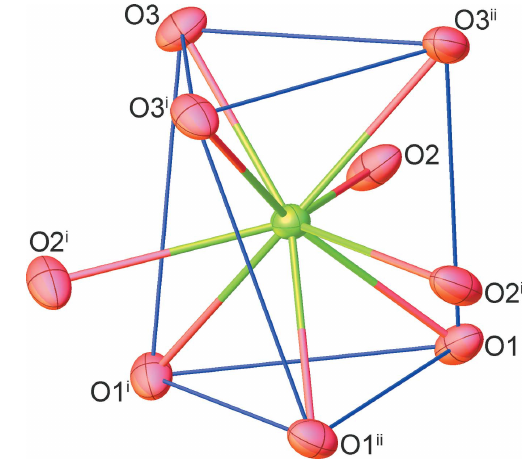
Figure 2 View of the distorted spherical tricapped trigonal prism (TCTPR-9) of the central Eu III ion in the title compound 1 . Symmetry codes: (i) (cid:3) x + y , (cid:3) x + 1, z ; (ii) (cid:3) y + 1, x (cid:3) y + 1, z .